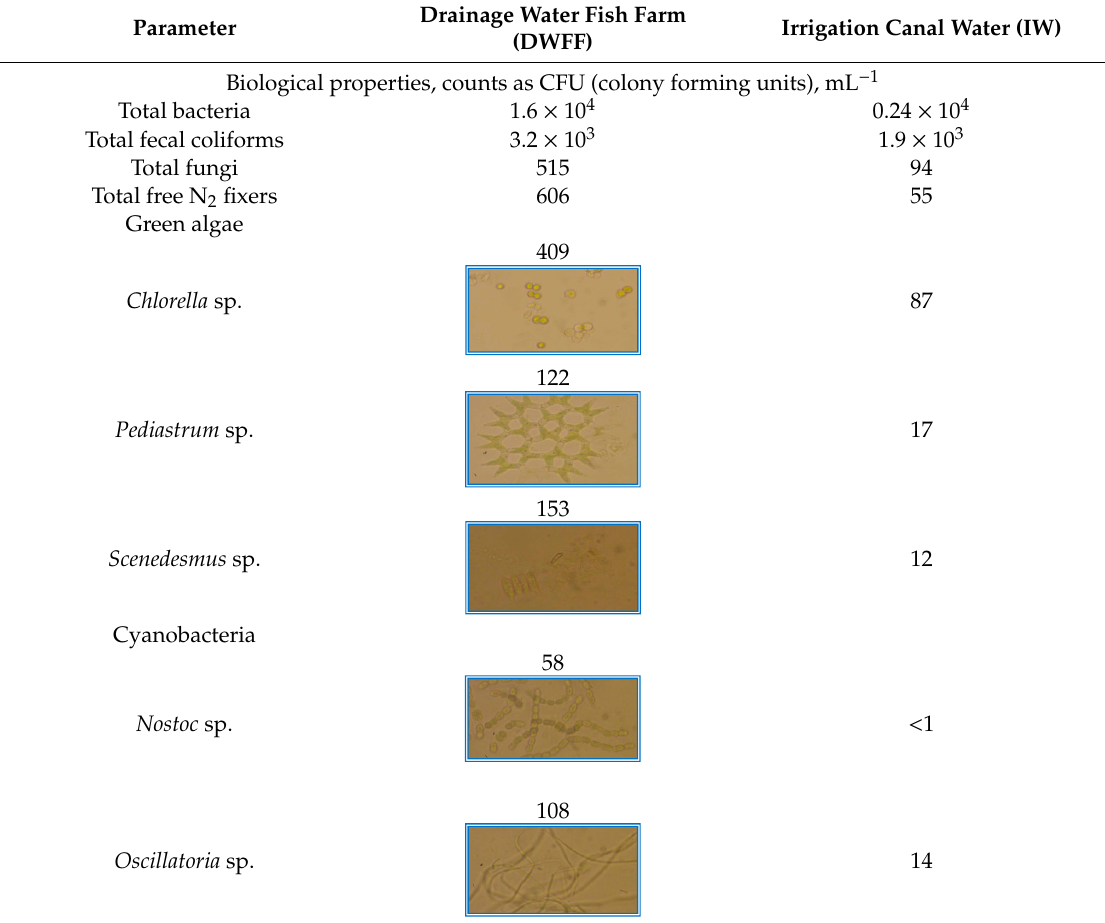
Table 4. Bio-component characteristics of the drainage water from fish farms and fresh irrigation water. Parameter